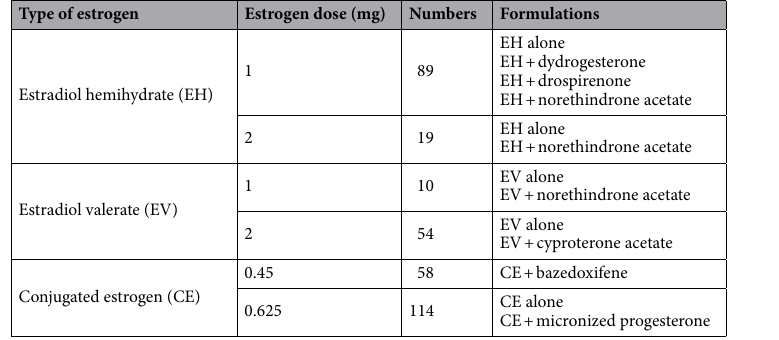
Table 1. Regimens of menopausal hormone therapy included in the